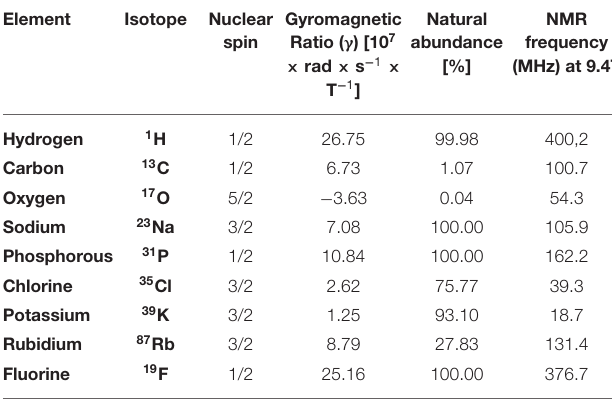
TABLE 3 | NMR-relevant properties of some nuclei. Data is adapted from references (139, 142, 143).